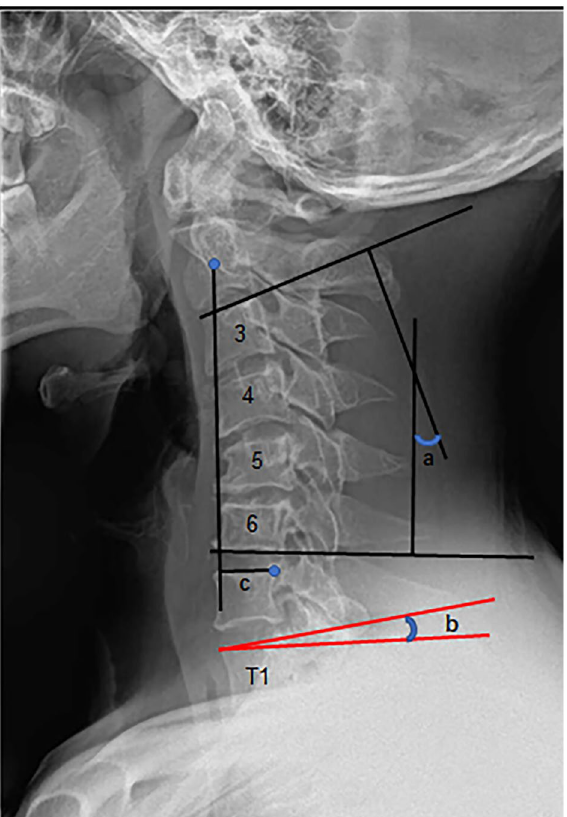
Figure 1. Radiographic measurements: ( a ) local Cobb angle (C3–6), ( b ) T1 slope, ( c ) C2–7 sagittal vertical